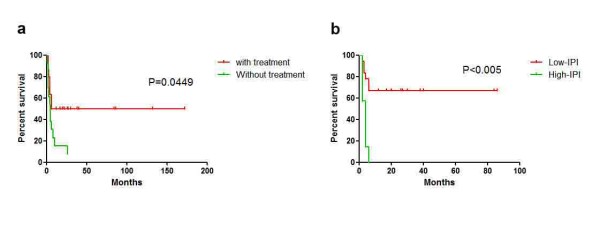
(a) The overall survival curve of 30 patients with treatment and 13 patients without treatment; (b) In treated patients, high IPI (n = 9) had worse prognoses than those with low IPI (n = 16) (p < 0.001).